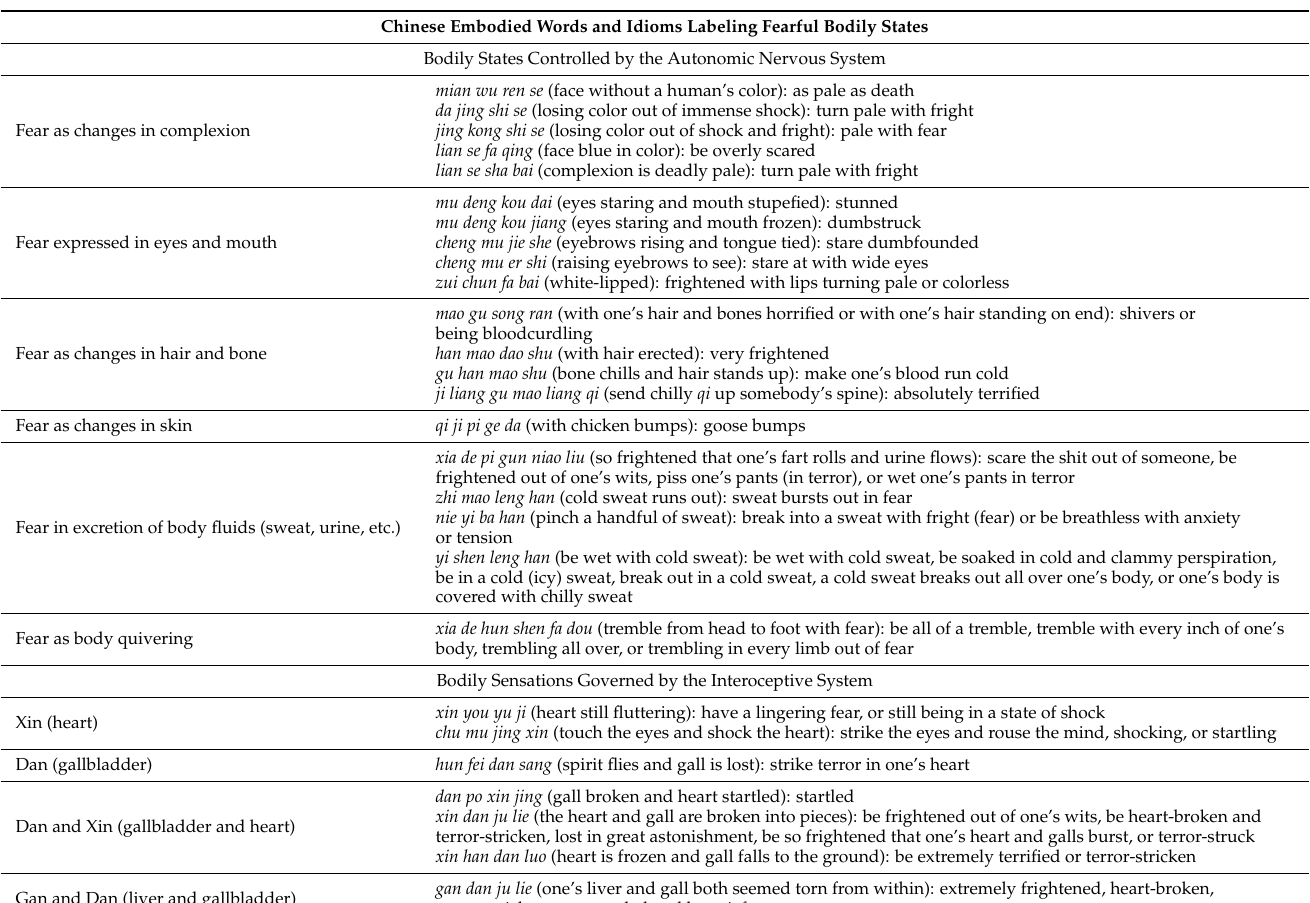
Table 1. Chinese embodied words and idioms labeling bodily states of fear . Chinese Embodied Words and Idioms Labeling Fearful Bodily States Bodily States Controlled by the Autonomic Nervous